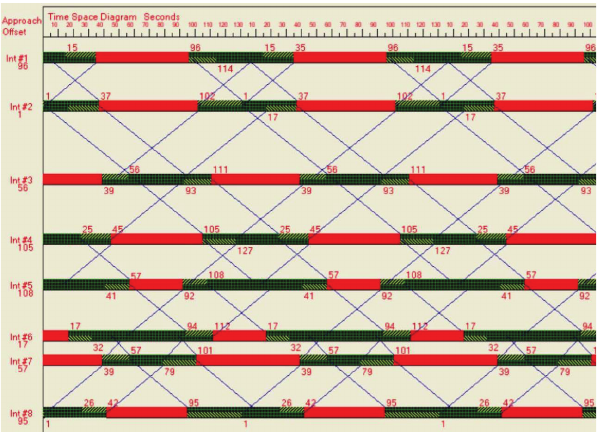
Figure 7: TSD of signal timing plan with proposed algorithm.